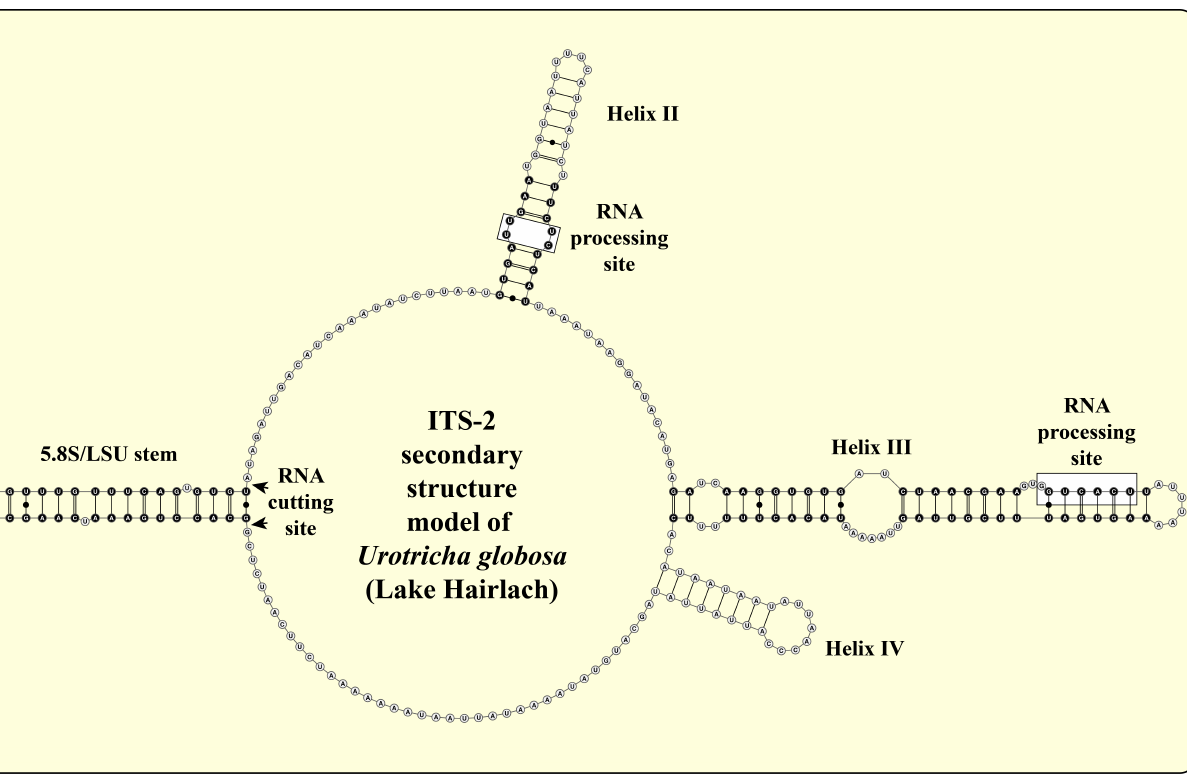
Figure 5. ITS-2 secondary structure of Urotricha globosa. Bases marked in black circles were used for the ITS-2/CBC approach. The RNA processing sites are highlighted in white boxes.